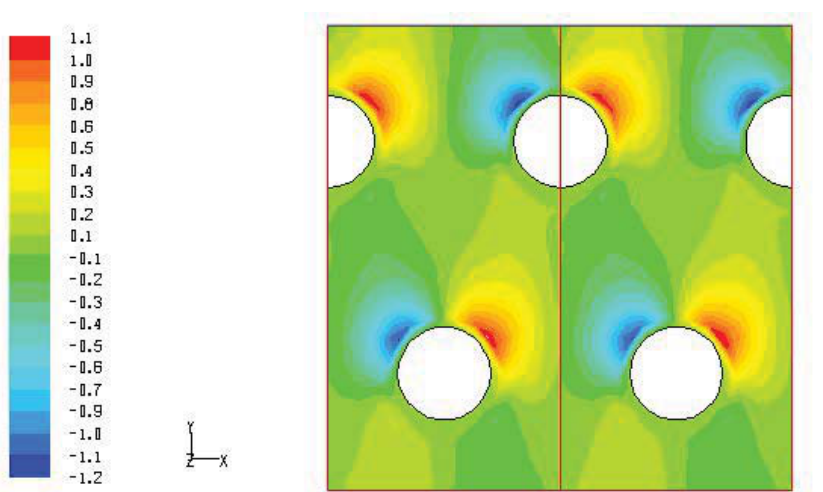
Figure 6: Main velocity component (y) in the contact plane